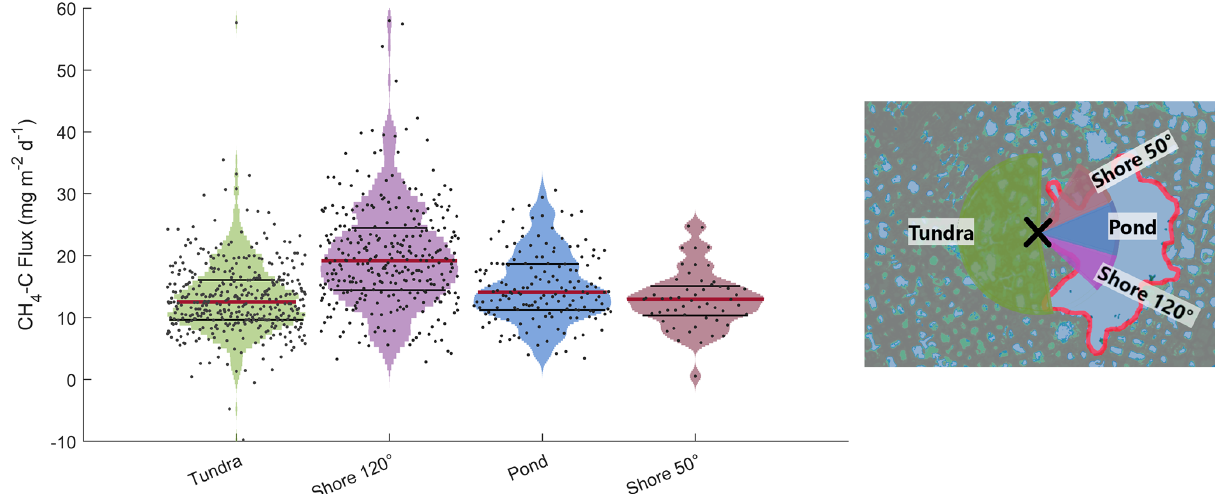
Figure 6. Violin plots of observed CH 4 emissions at the EC tower separated into four different wind sector classes. A violin plot shows the distribution of measurements along the y axis – the width of the shapes indicates how frequently a certain y value occurred. Medians of CH 4 emission distributions are shown as red lines, and 75th and 25th percentile are shown as black lines. On the right, the wind sectors with the eddy covariance tower in the center (black cross) are